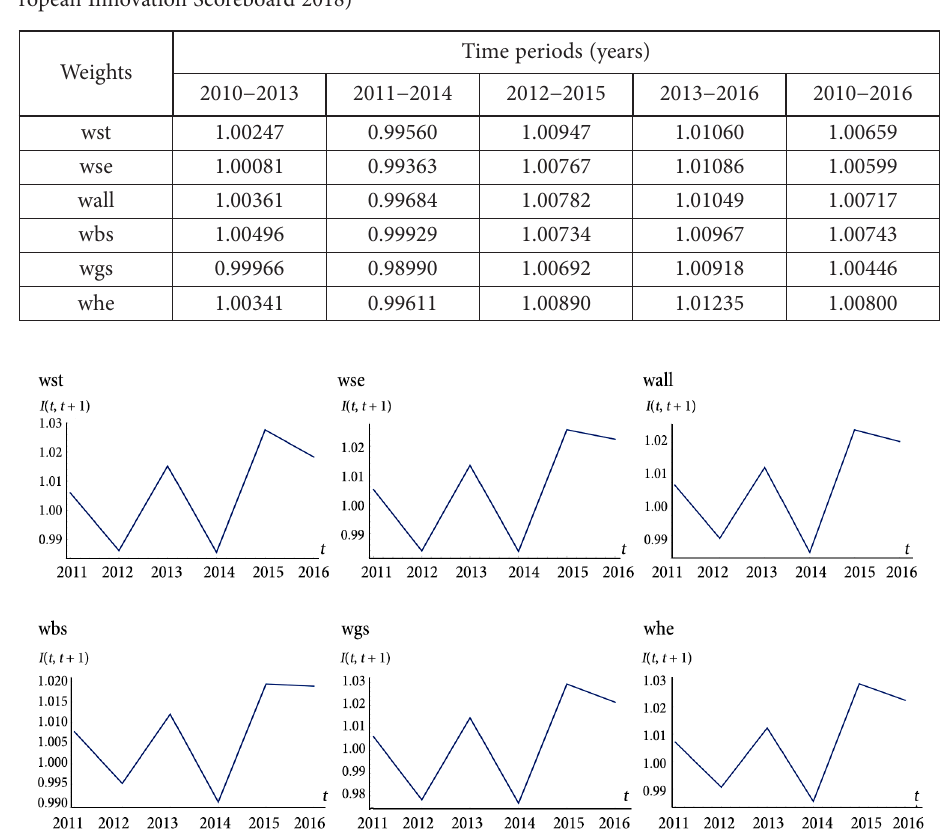
Figure 1. The one-year innovativeness changes depending on the system of weights and calculated for the EU-28 (source: own elaboration based on the data of the European Statistical Office – Eurostat and European Commission, 2018. European Innovation Scoreboard